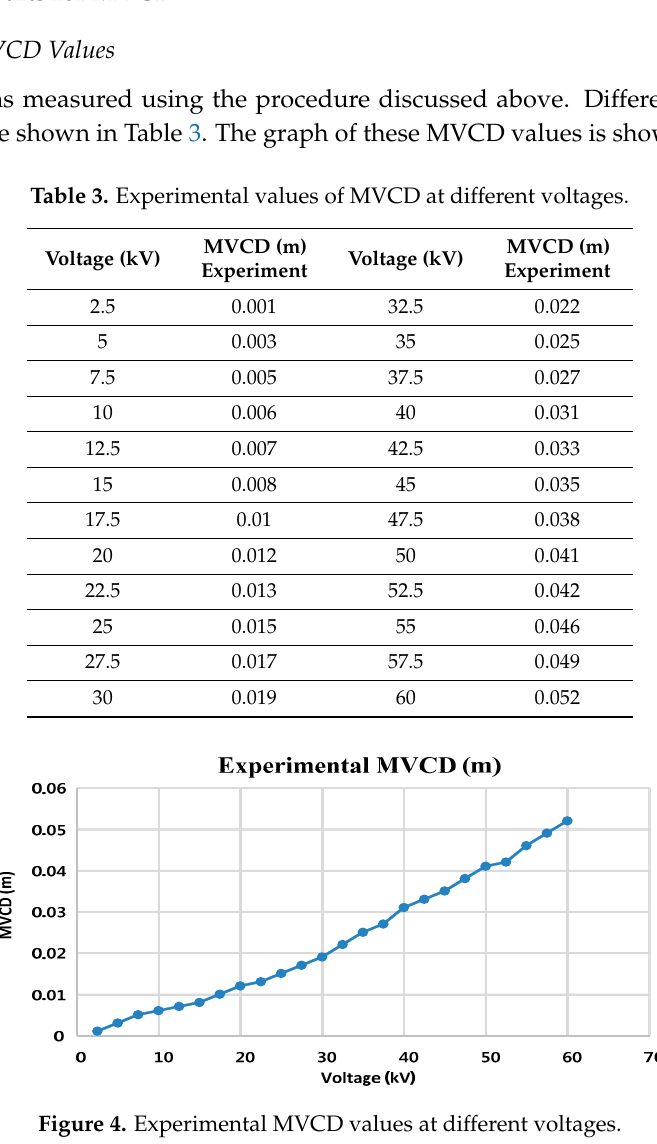
Figure 4. Experimental MVCD values at different voltages.